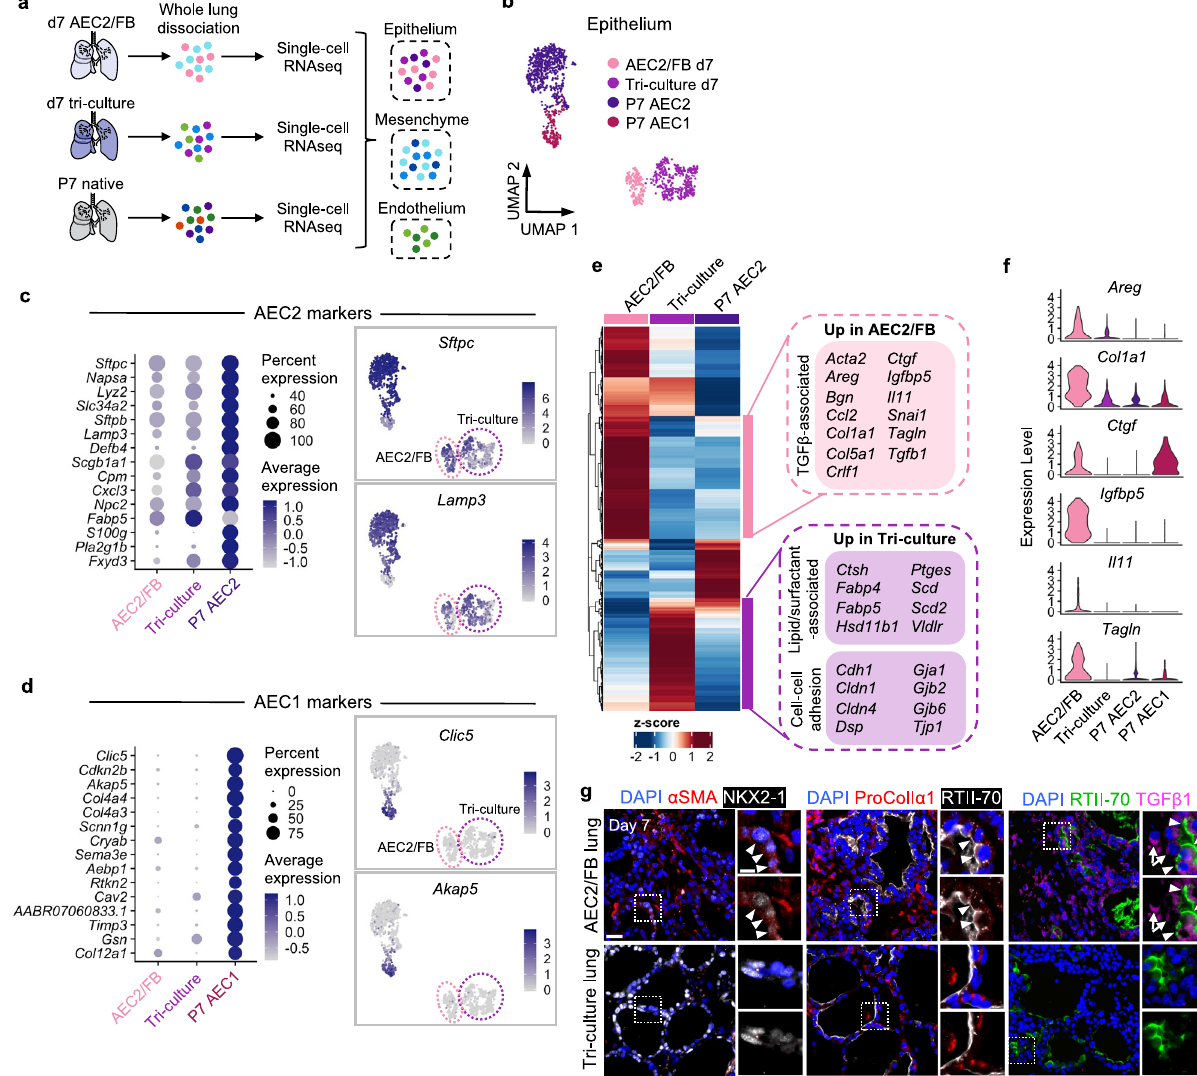
Fig. 3 scRNAseq demonstrates a pro- fi brotic signature in AEC2/FB co-culture lung AEC2s. a Schematic of scRNAseq analysis of engineered and P7 native rat lungs. b Merged UMAP embedding of scRNAseq data for engineered epithelia and native P7 AECs. Populations have been merged into a single UMAP to facilitate phenotypic comparisons. c , d Dot plots (left) showing scaled expression and feature plots (right) showing normalized expression data projected onto the scRNAseq data from b for top AEC2 markers ( c ) and top AEC1 markers ( d ) in engineered lung and P7 native epithelial populations. e Heatmap of consensus DEGs across engineered epithelia and P7 native AEC2s, with select genes of interest indicated. f Violin plots of select TGF β -associated genes identi fi ed from e to be enriched in AEC2/FB epithelium. g Immunostaining for protein expression of α SMA, ProColI α 1, and TGF β 1 in d7 engineered lungs. Arrowheads, epithelial cells positive for these markers in AEC2/FB lung. Arrows, FBs positive for TGF β 1 in AEC2/FB lung. Scale bars, 25 μ m; magni fi ed region, 10 μ m. Adjustments to contrast of individual color channels were performed identically across all